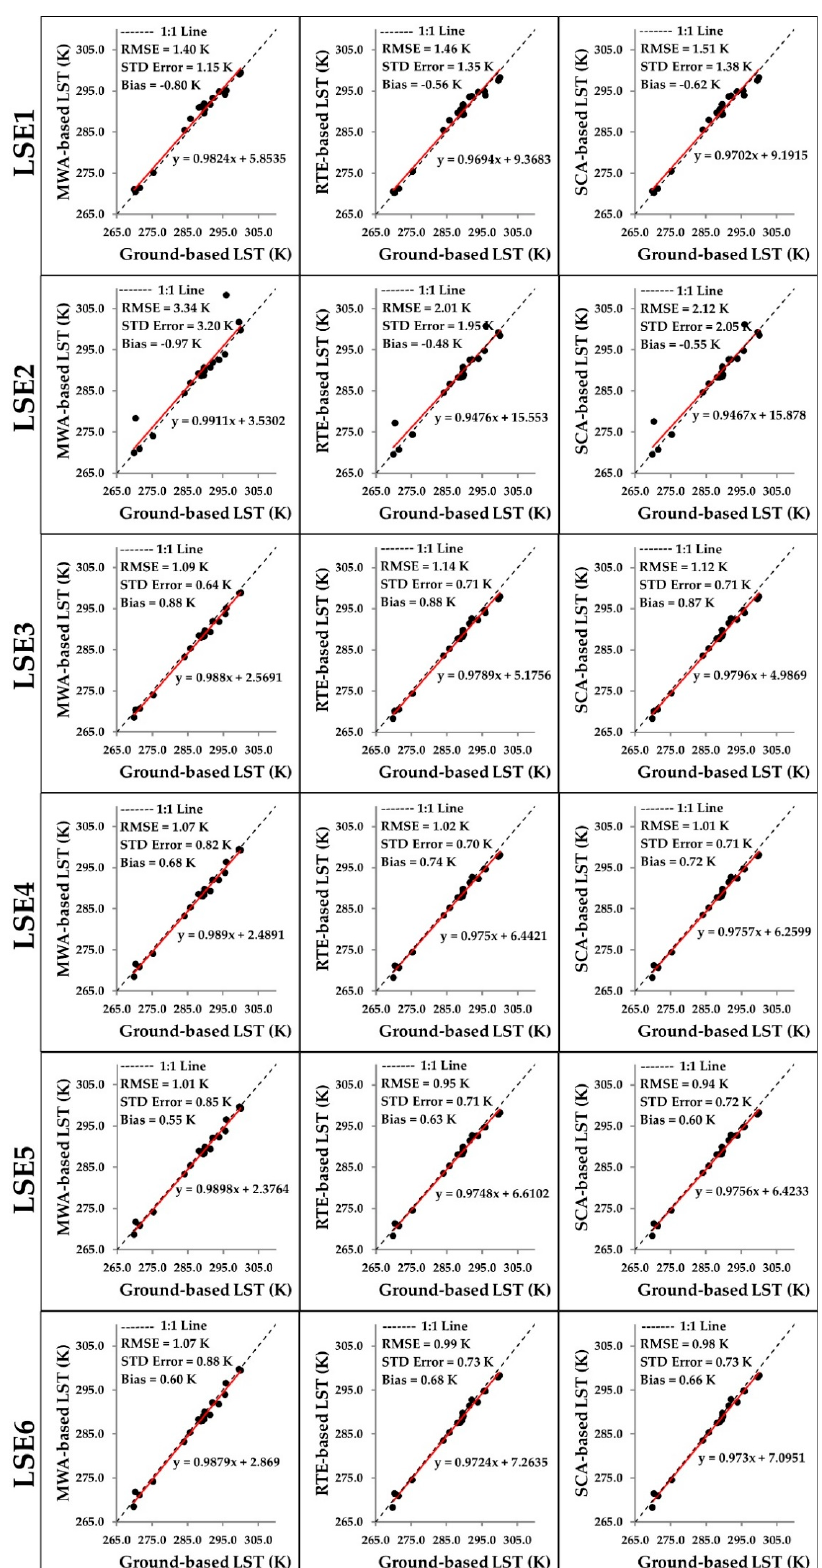
Figure 6. Nighttime LST from Landsat 8, period 2013–2019 (see Appendix A): Accuracy assessment of MWA, RTE, and SCA retrieval methods with di ff erent LSE models at the nine SURFRAD and ARM